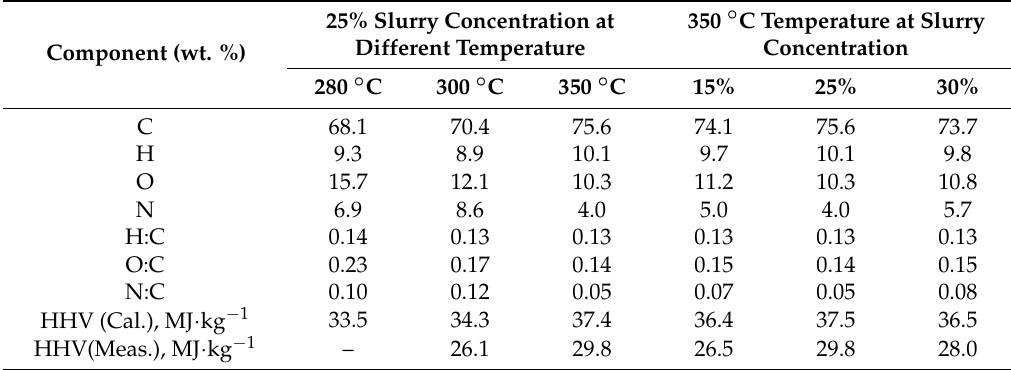
Table 4. Ultimate analysis and higher heating value (HHV) of the microalgae bio-crude.